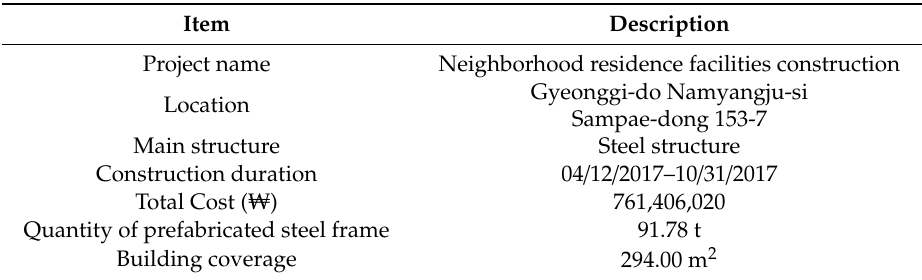
Table 6. Overview of the case study project.